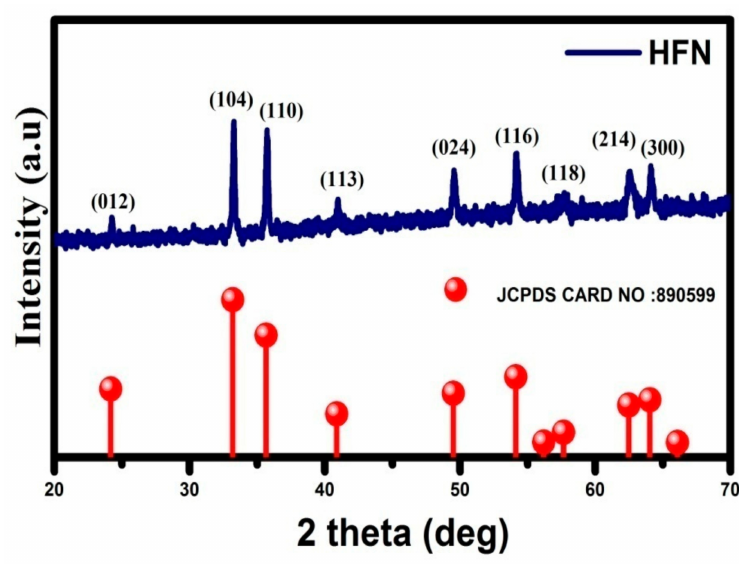
Figure 1. X-RD pattern of synthesized FNH